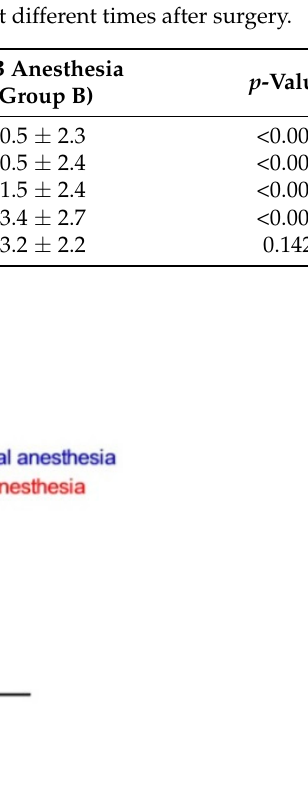
Table 3. Results of sensory recovery over time after surgery in Group